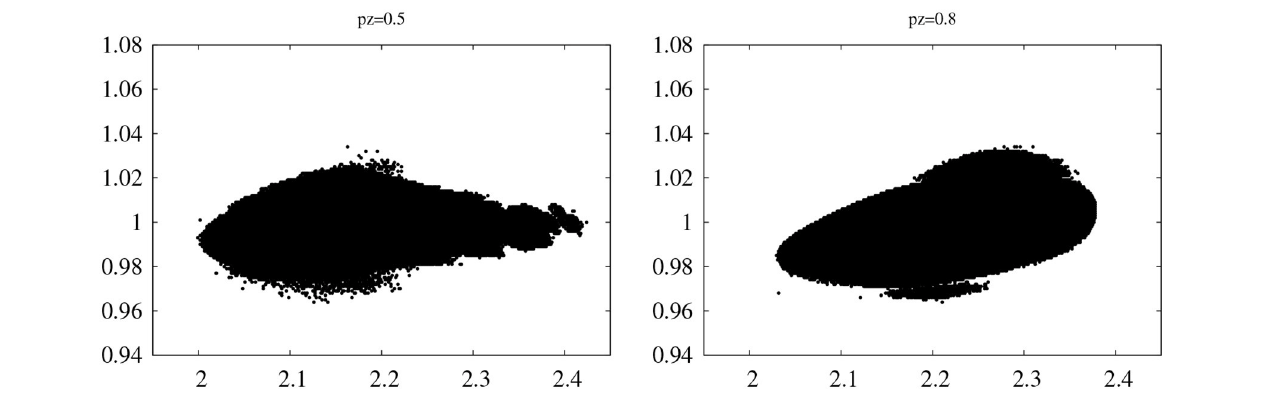
FIGURE 5 | Stability regions with initial conditions on the tori of the VF 3 identified by p z = 0.5 and p z = 0.8. Horizontal axis: α . Vertical axis r . See text for more details.